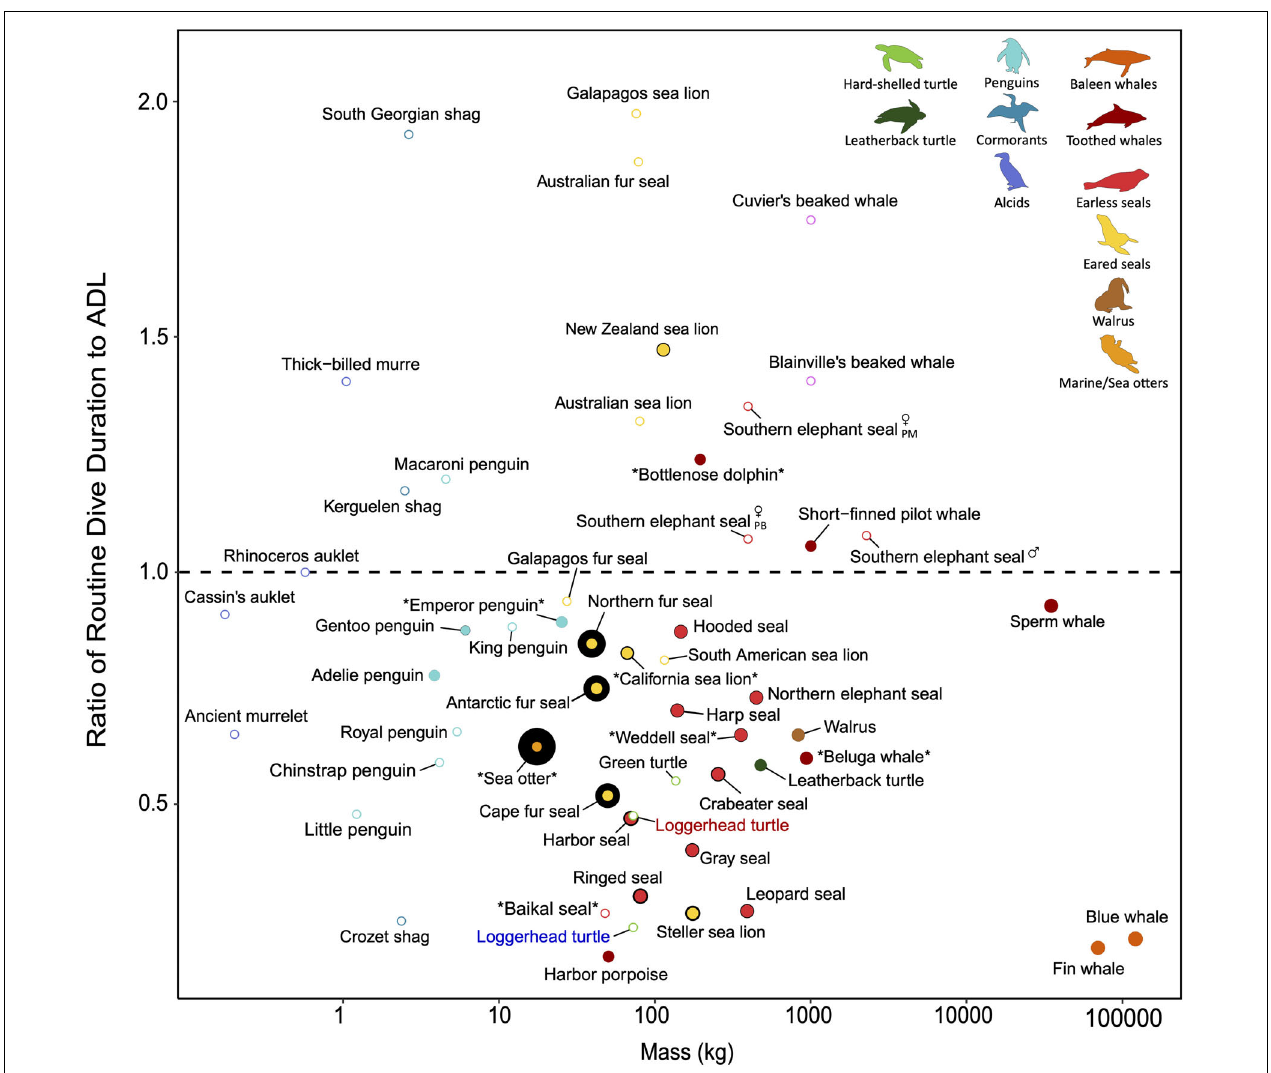
FIGURE 5 | The relative amount of insulation across divers with varying dive performance. Dive performance here is defined as the ratio of routine dive duration to aerobic dive limit (ADL). A ratio greater than 1 indicates diving behavior exceeds what is expected based on ADL and diving performance may be close to physiological limits. Species denoted by asterisks have ADLs determined by lactate measurements; all other species’ ADLs are estimated from oxygen stores and oxygen consumption rates (cADL) or behaviorally (bADL). Please refer to Supplementary Table S3 for the various methods used to estimate ADL when interpreting the figure. The relative size of the colored points indicates blubber thickness and the black border around the colored points represents fur/feather density. Open points are species for which blubber thickness and/or fur/feather density are not available to the best of our knowledge, but are included for interspecific comparison. In addition to variation introduced by how ADL is estimated (see method for each species in Supplementary Table S3 ), ADLs may vary across seasons and between sexes (especially for sexually dimorphic species, e.g., southern elephant seal; PM, post-molt foraging trip; PB, post-breeding foraging trip). The ADL of ectotherms will differ in cold vs. warm water (e.g., blue vs. red labeled loggerhead turtle) due to the temperature sensitivity of their metabolism. Generally, most species dive within their ADL, including earless seals and baleen whales, and reliance on blubber rather than fur is common among the larger divers. Other species, such as the Australian fur seal and South Georgian shag, routinely exceed their ADL. In addition to ecological factors (e.g., benthic foraging), increased thermoregulatory costs associated with a reduced air layer in the fur/feathers at depth may contribute to the need of performing near physiological limits for these relatively smaller divers. Refer to Supplementary Table S3 for data